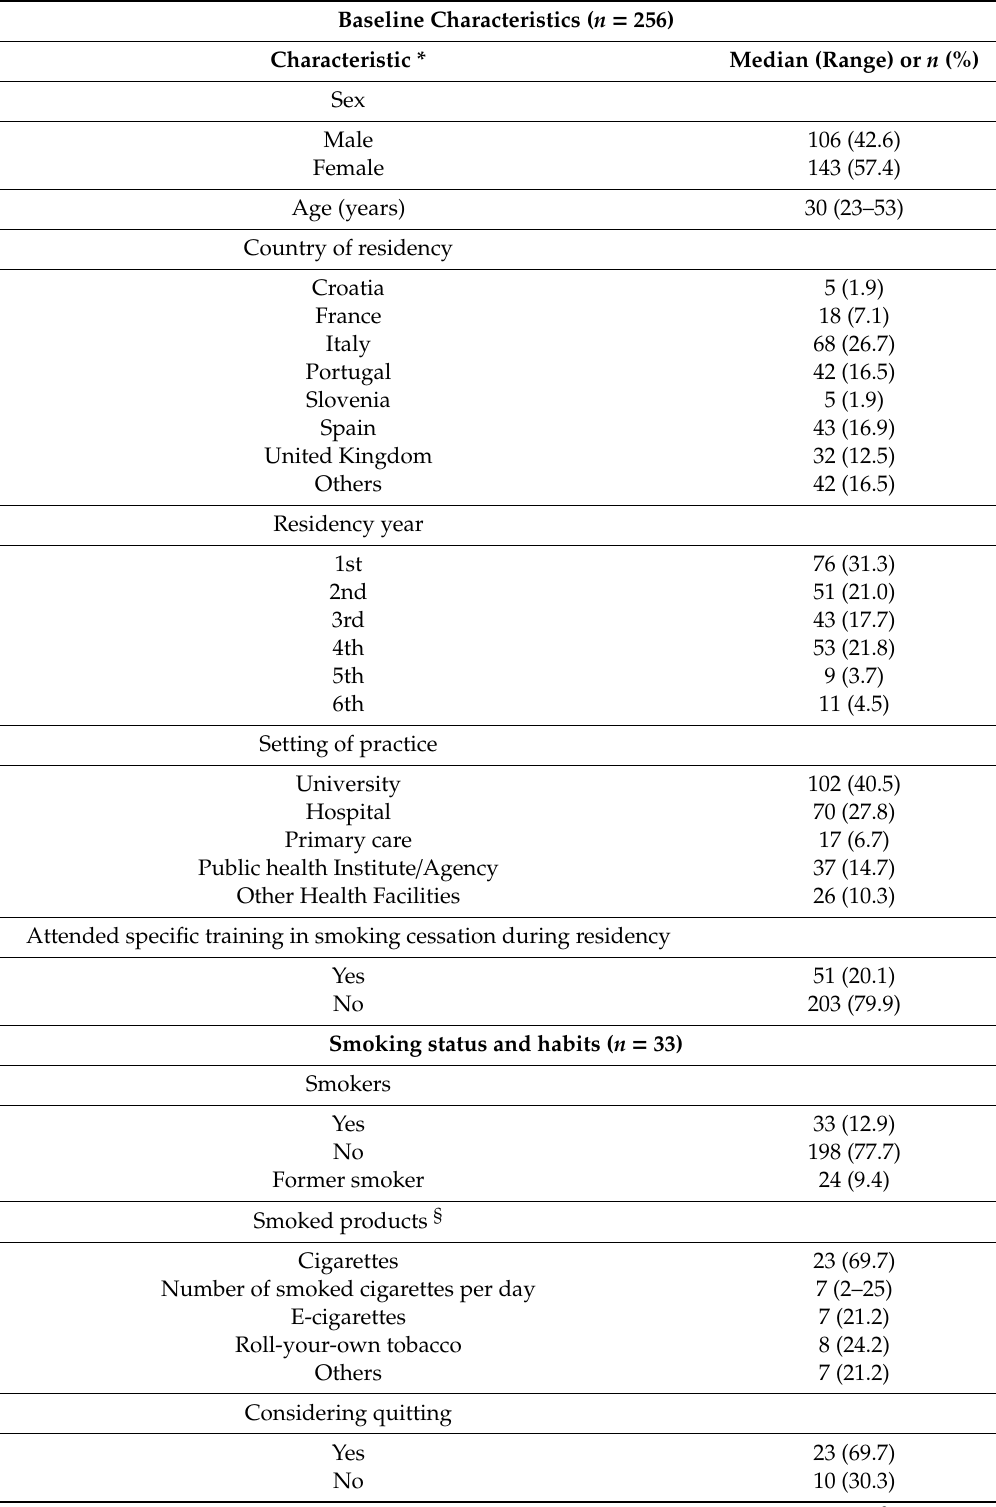
Table 1. Baseline characteristics of the study